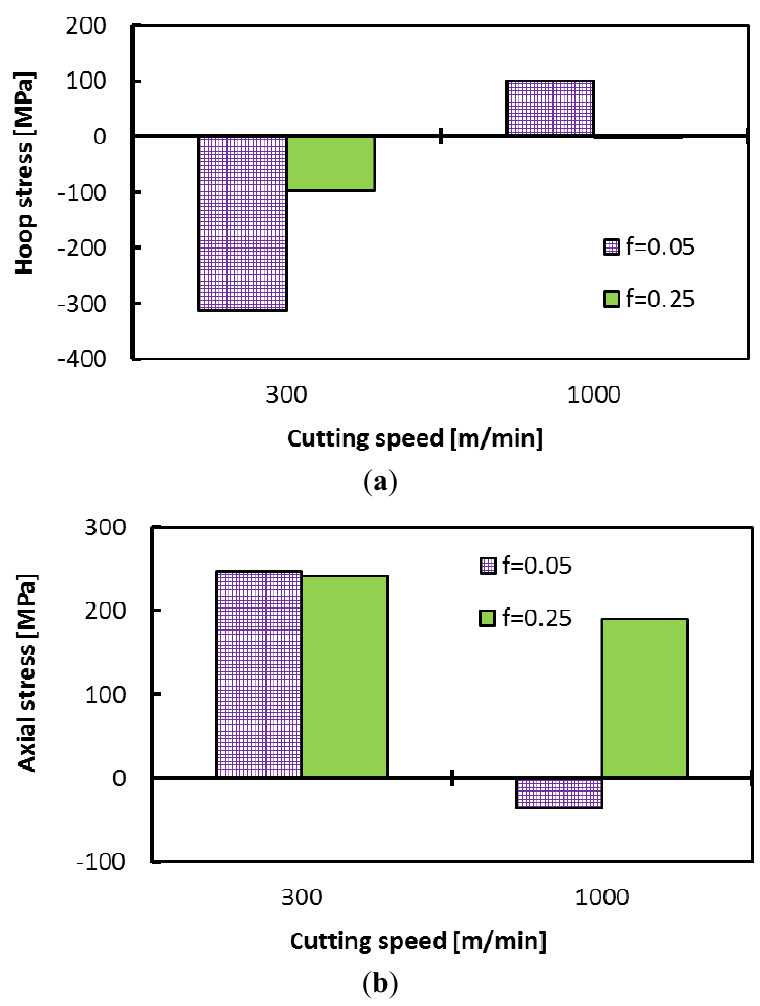
Figure 17. Effect of cutting speed on hoop ( a ) and axial ( b ) surface residual